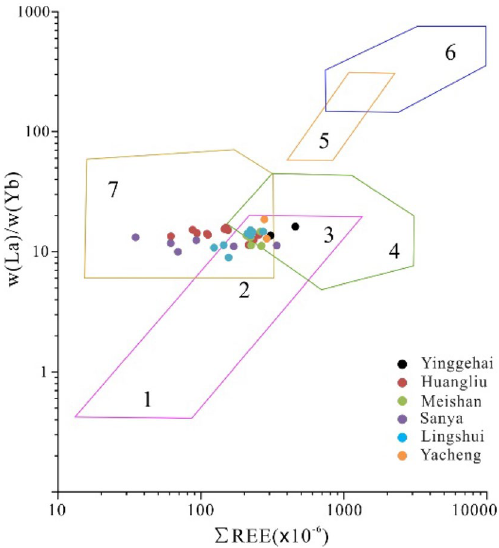
Figure 9. Parent rock discrimination from La/Yb vs ∑REE for Cenozoic sediments from the junction area of Yinggehai and Qiongdongnan basins 58 . 1: oceanic tholeiitic basalt, 2: continental tholeiitic basalt, 3: alkali basalt, 4: granite, 5: kimberlite, 6: carbonate rocks, and 7: sedimentary rock and calcareous